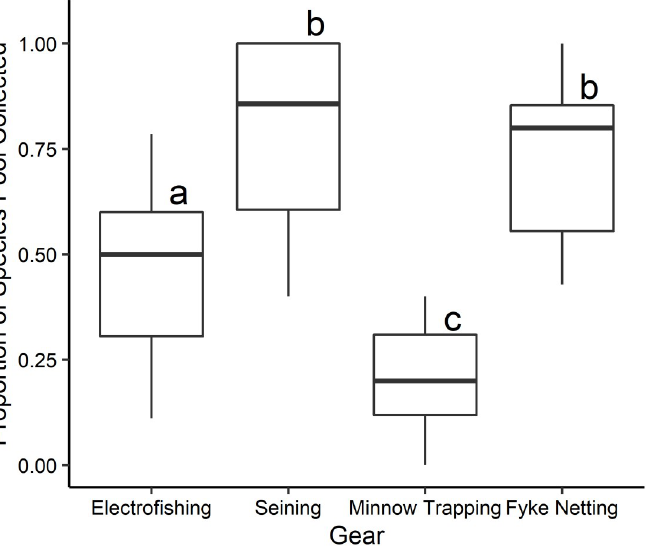
Fig 2. Boxplots for proportion of species pool collected across oxbows for each sampling method. Letters denote significant differences between sampling methods.